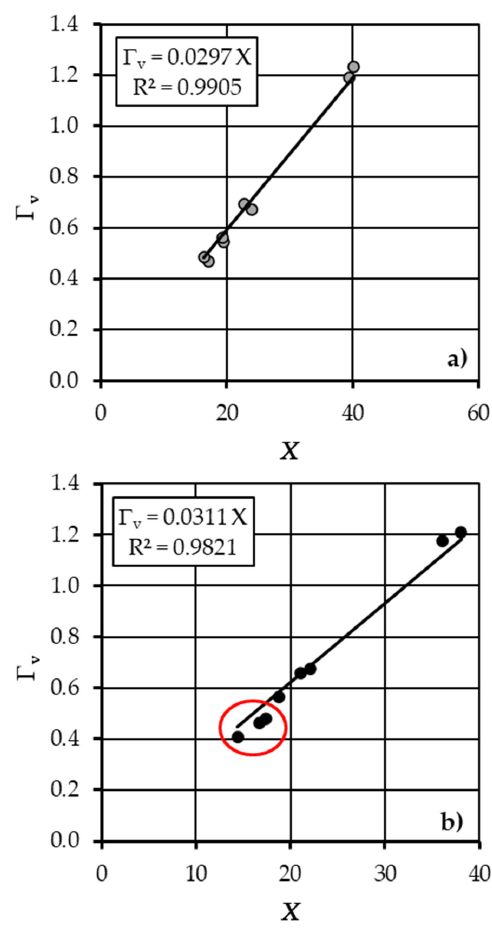
Figure 3. Comparison between the experimental pairs ( X , Γ v ) and Equation (10) with a = 0.0297 for BC = 6 kg m − 2 ( a ) and a = 0.0311 for BC = 12 kg m − 2 ( b ). The red box includes experimental pairs with the highest BC value and the lowest X values.